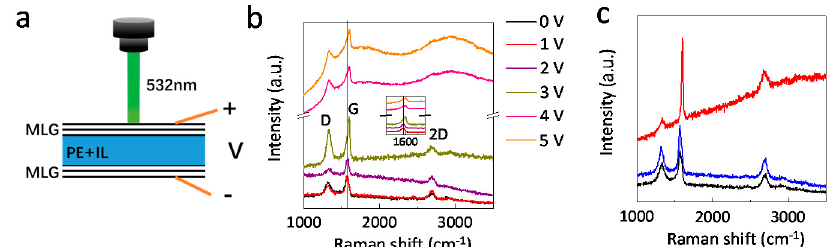
Figure 4. In-situ Raman measurements of the ionic liquid intercalated multilayer graphene device. ( a ) Schematic of the in-situ Raman measuring process. ( b ) Raman spectra of the surface multilayer graphene under different bias voltages. The inset shows the zoom in for G peak. ( c ) Raman spectra of pristine (black), intercalated (red) and deintercalated (blue) surface multilayer graphene.